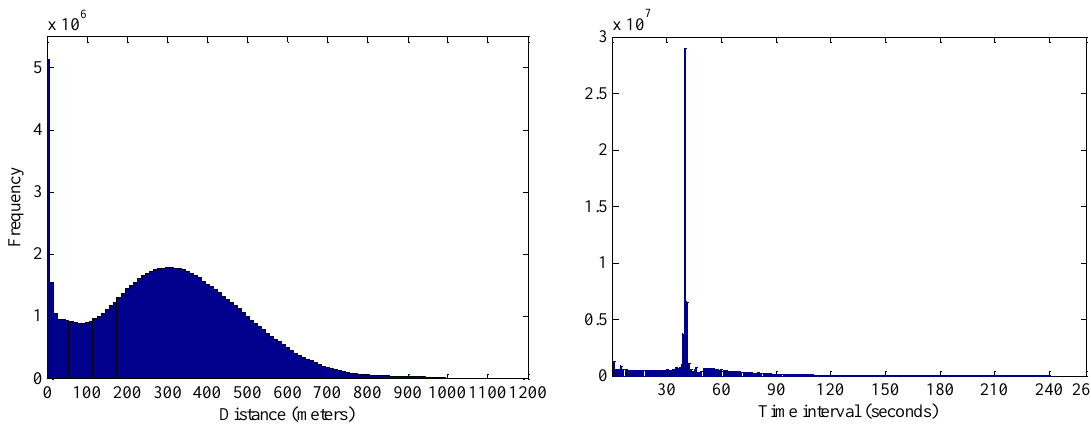
Figure 3. Histogram of distances ( left panel ) and time intervals ( right panel ) of all pairs of consecutive GPS points less than